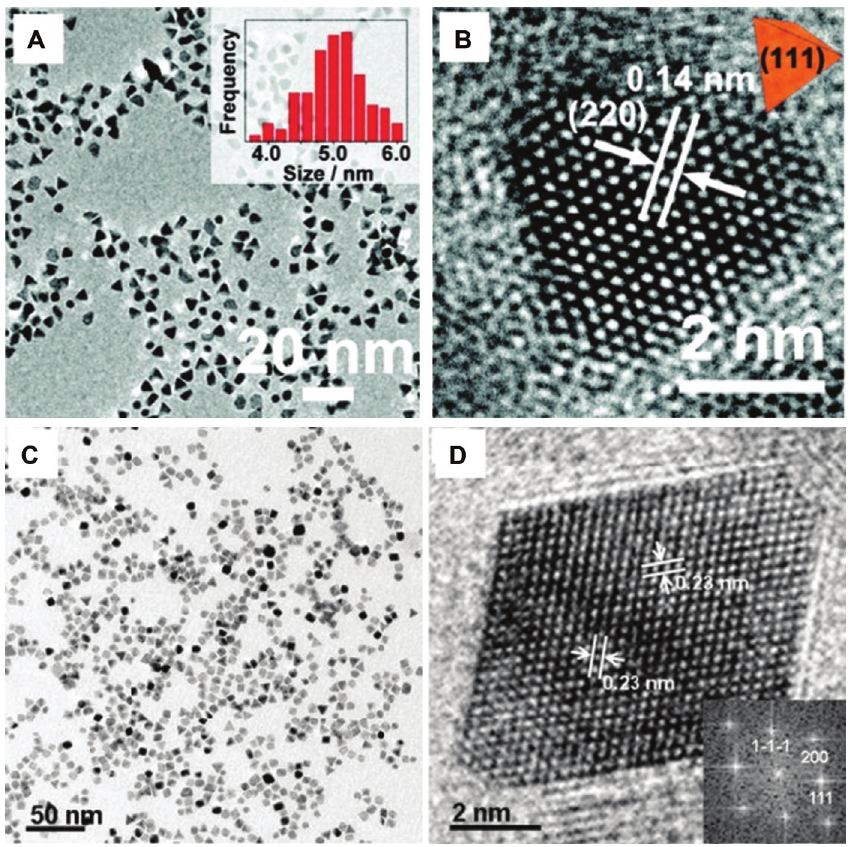
Pd octahe- 52 48